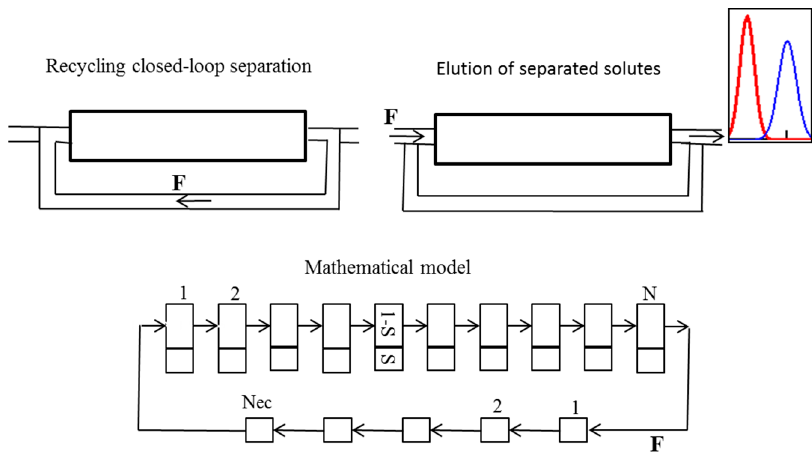
Figure 6. Operating scheme and principle of the non-ideal recycling mode of a CLR CCC separation and the applied mathematical model .